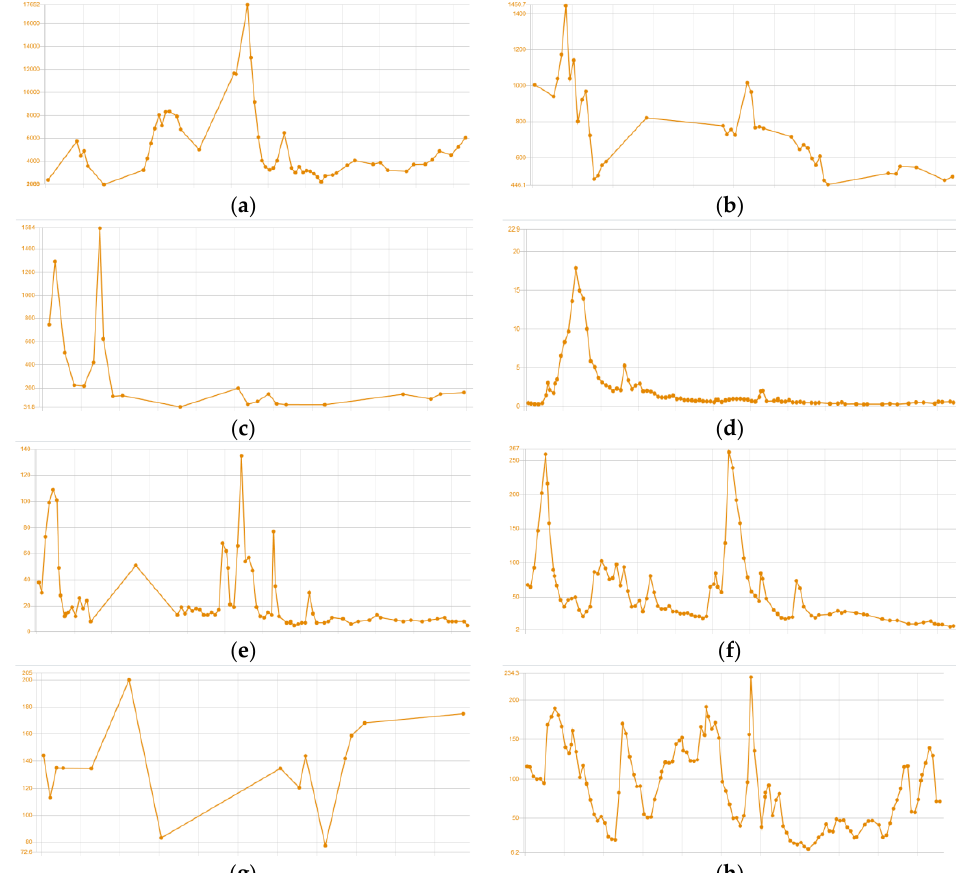
Figure 2. Trend chart of HLH-relatedlaboratory tests: ( a )ferritin [ μ/L] ; ( b ) fibrinogen [mg/dL] ; ( c ) interleukin 6 [pg/mL]; ( d ) bilirubin [mg/dL]; ( e ) aspartate aminotransferase [IU/L]; ( f ) alanine aminotransferase [IU/L]; ( g ) triglycerides [mg/dL]; ( h ) c-reactive protein [mg/L]. Each box on the x-axis corresponds to 1 day.